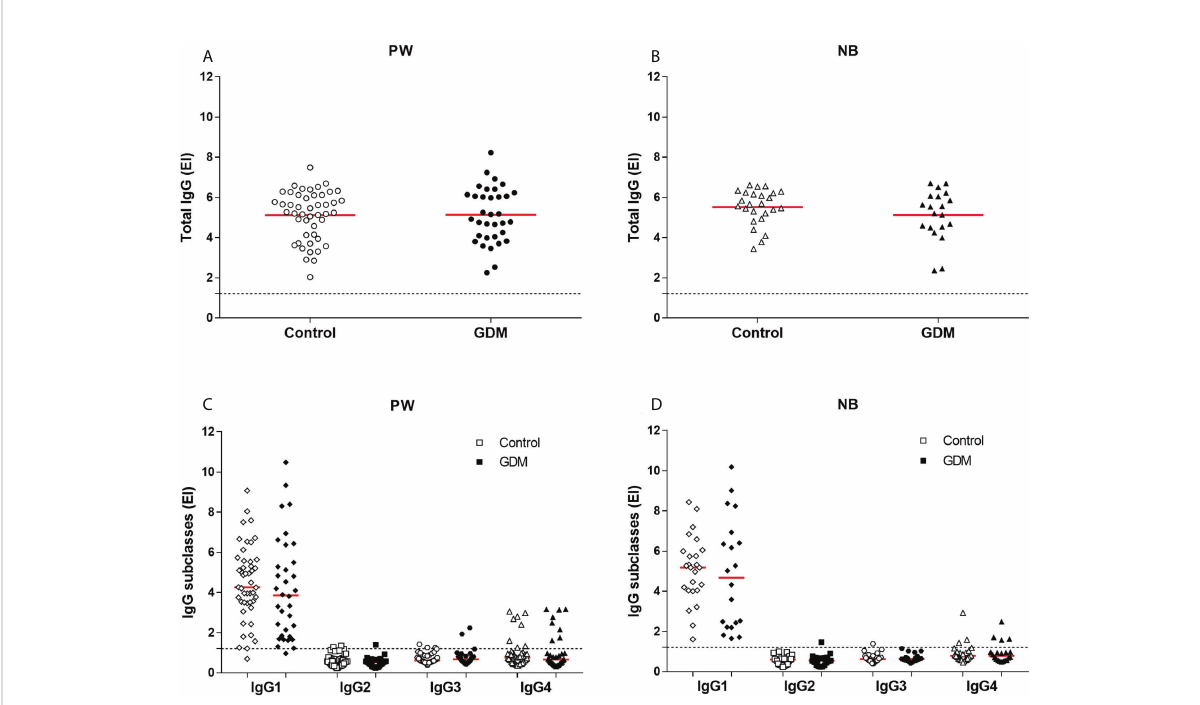
FIGURE 1 Anti- T. gondii antibody levels. (A) Total IgG in serum samples from 81 pregnant women (34 GDM and 47 controls) and (B) 45 newborns (20 GDM and 25 controls). (C) IgG1, IgG2, IgG3 and IgG4 in serum samples from 81 pregnant women (34 GDM and 47 controls) and (D) 45 newborns (20 GDM and 25 controls). The red line represents the mean (total IgG) and median (subclasses) of the values. The dashed line represents the cut-off value (EI:1,2). PW, Pregnant women; NB, Newborn; EI, ELISA Index; GDM, Gestational diabetes